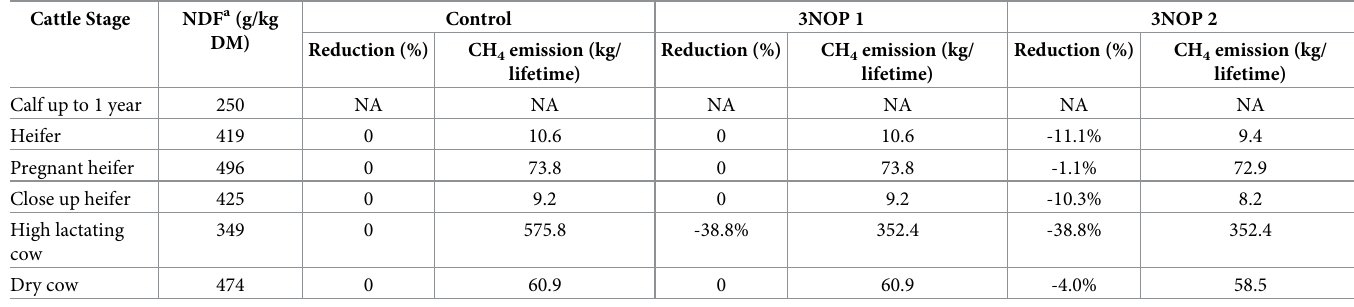
Table 1. Enteric methane reduction rates and total emissions per life cycle at different dairy growing stages for baseline and 3NOP treatment scenarios. Cattle Stage NDF a